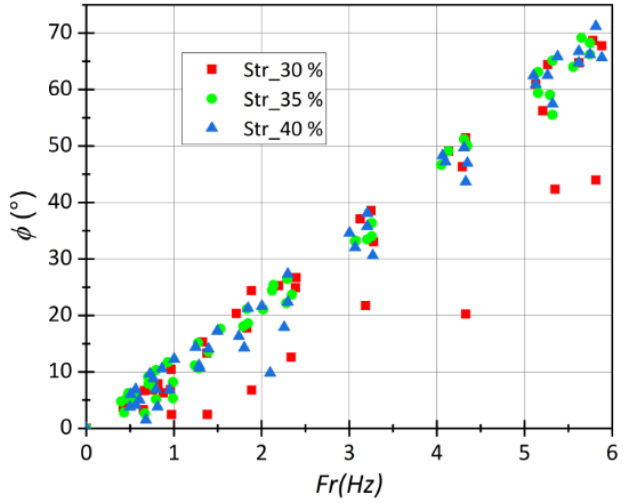
Figure 17. Phase shift between pressure drop and velocity for different regenerator structures, strokes, lengths, and temperature gradients.